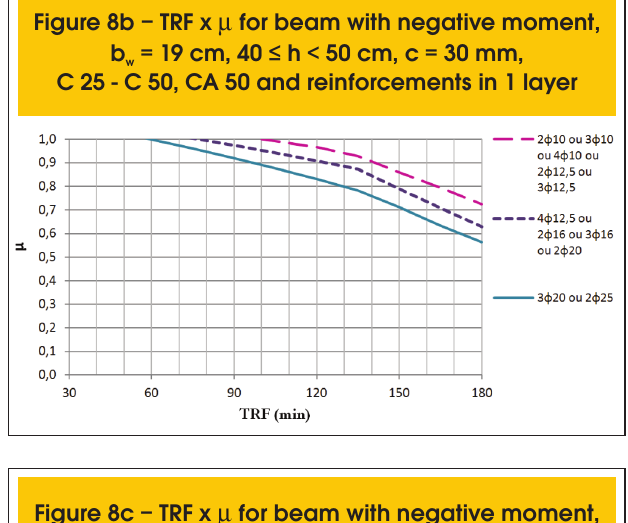
Figure 7f – TRF x m for beam with positive moment, b = 25 cm, 40 ≤ h ≤ 60 cm, c = 40 mm, w